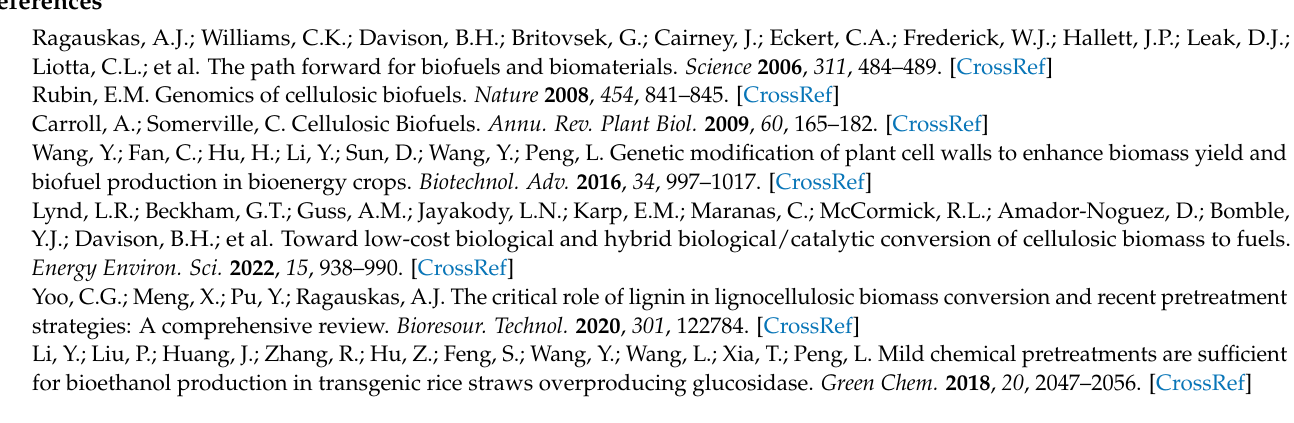
Table S1: Characteristic chemical bonds of FT-IR spectra presented in Figure